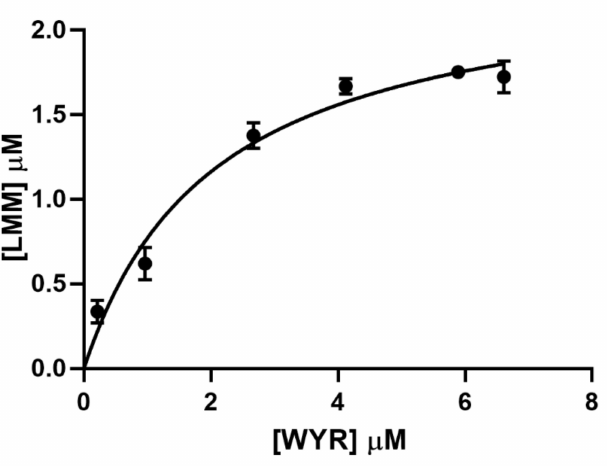
Figure 2. WYR promotes LMM sedimentation. Each point represents mean ± SEM; N =